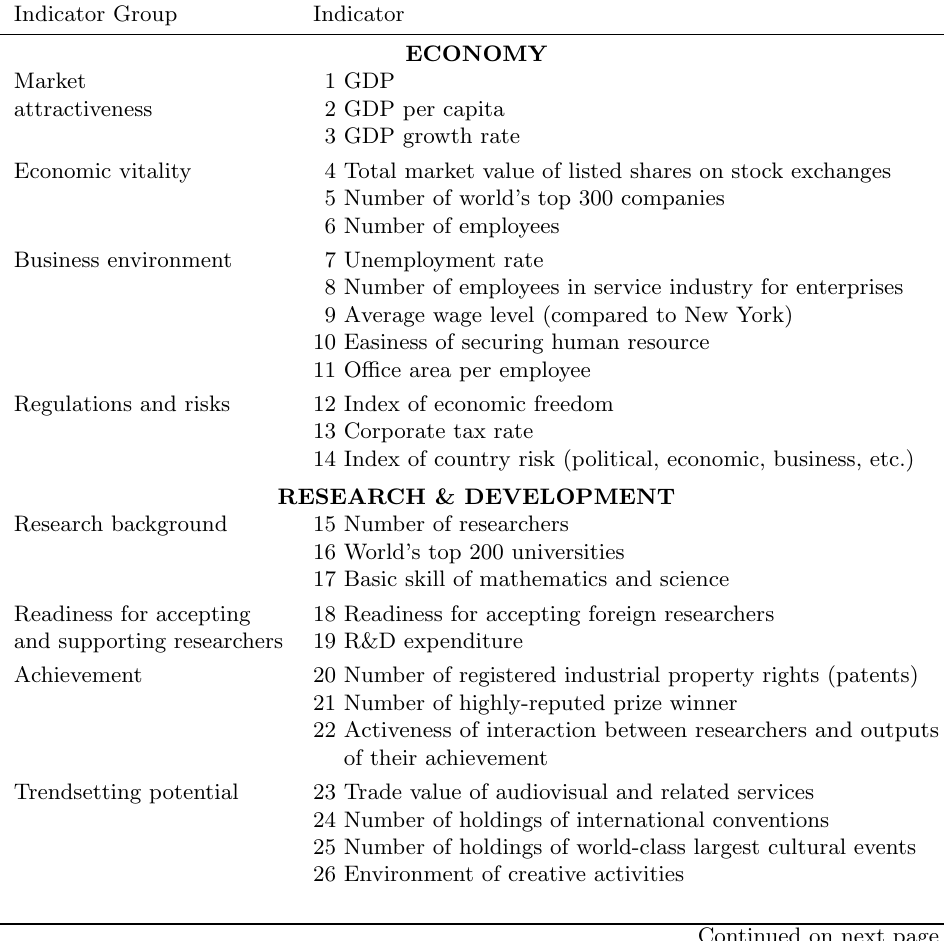
Table 1: List of performance indicators of the